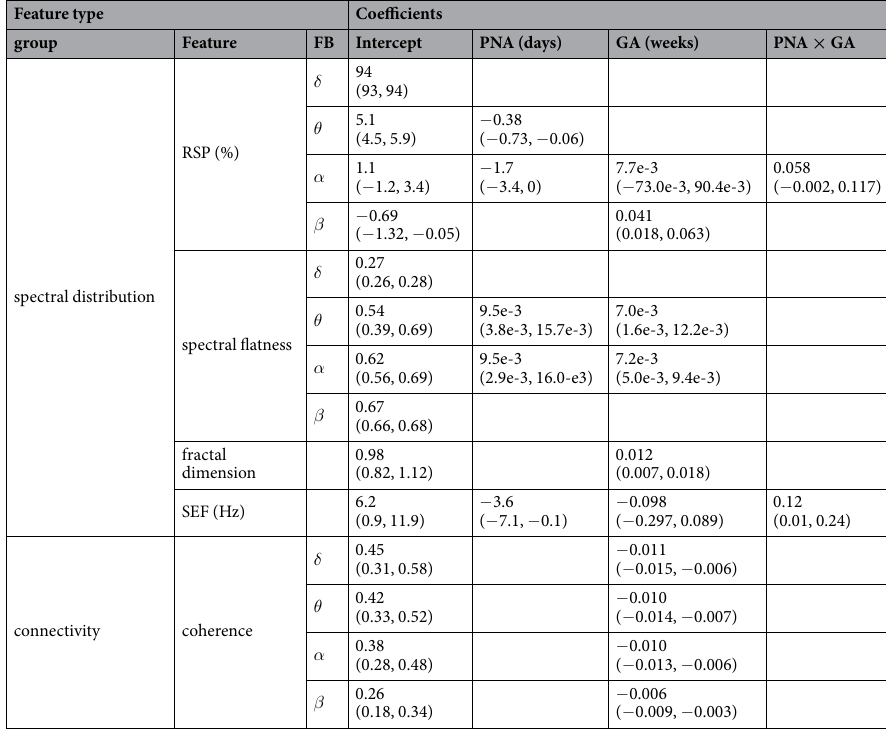
Table 3. Estimates (95% confidence intervals) of fixed-effect coefficients for EEG features in the spectral distribution and inter-hemispheric connectivity groups. Coefficients of the mixed-model include intercept, gestational age (GA, age at birth in weeks), postnatal age (PNA, time after birth in days), and the interaction term between PNA and GA (PNA × GA). Frequency bands (FB): 0.5–3 Hz ( δ ), 3–8 Hz ( θ ), 8–15 Hz ( α ), and 15–30 Hz ( β ). RSP: relative spectral power; SEF: spectral edge